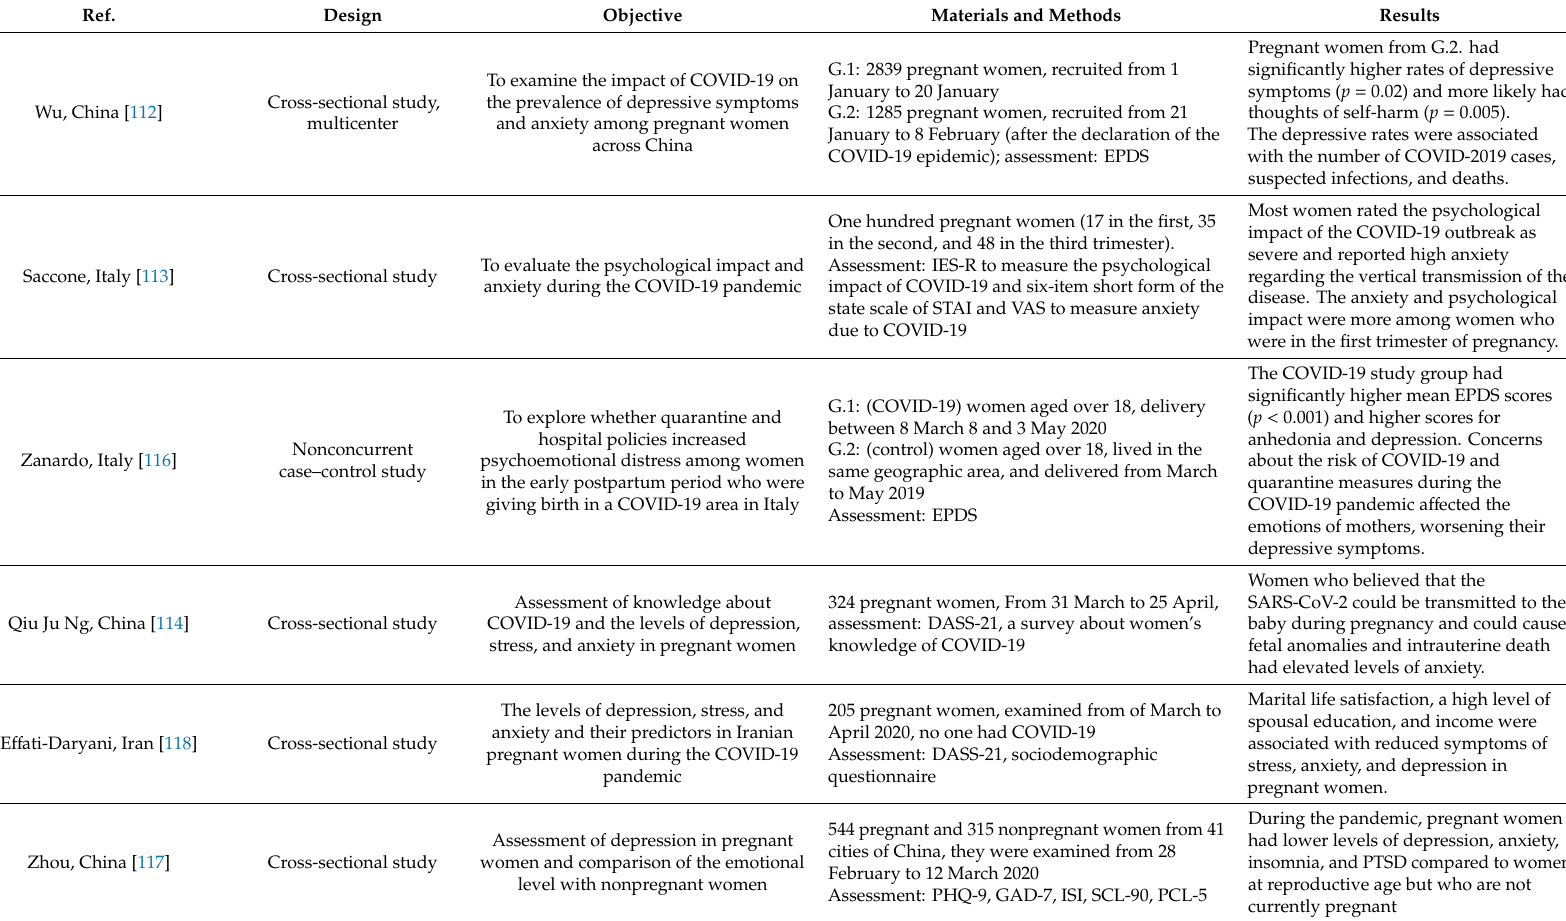
Table 3. Emotional state of pregnant women during the COVID-19